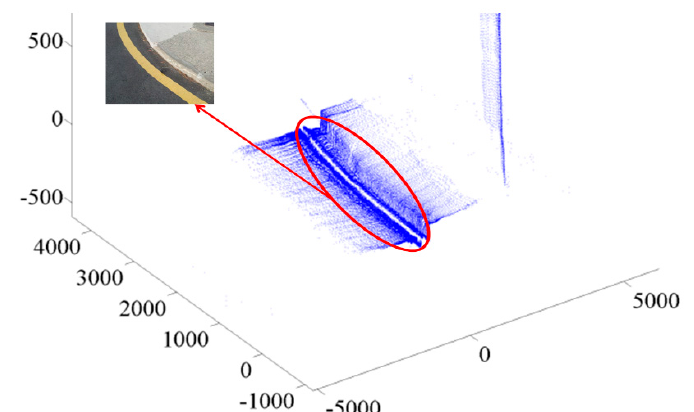
Figure 5. Coordinate transformation of map data.